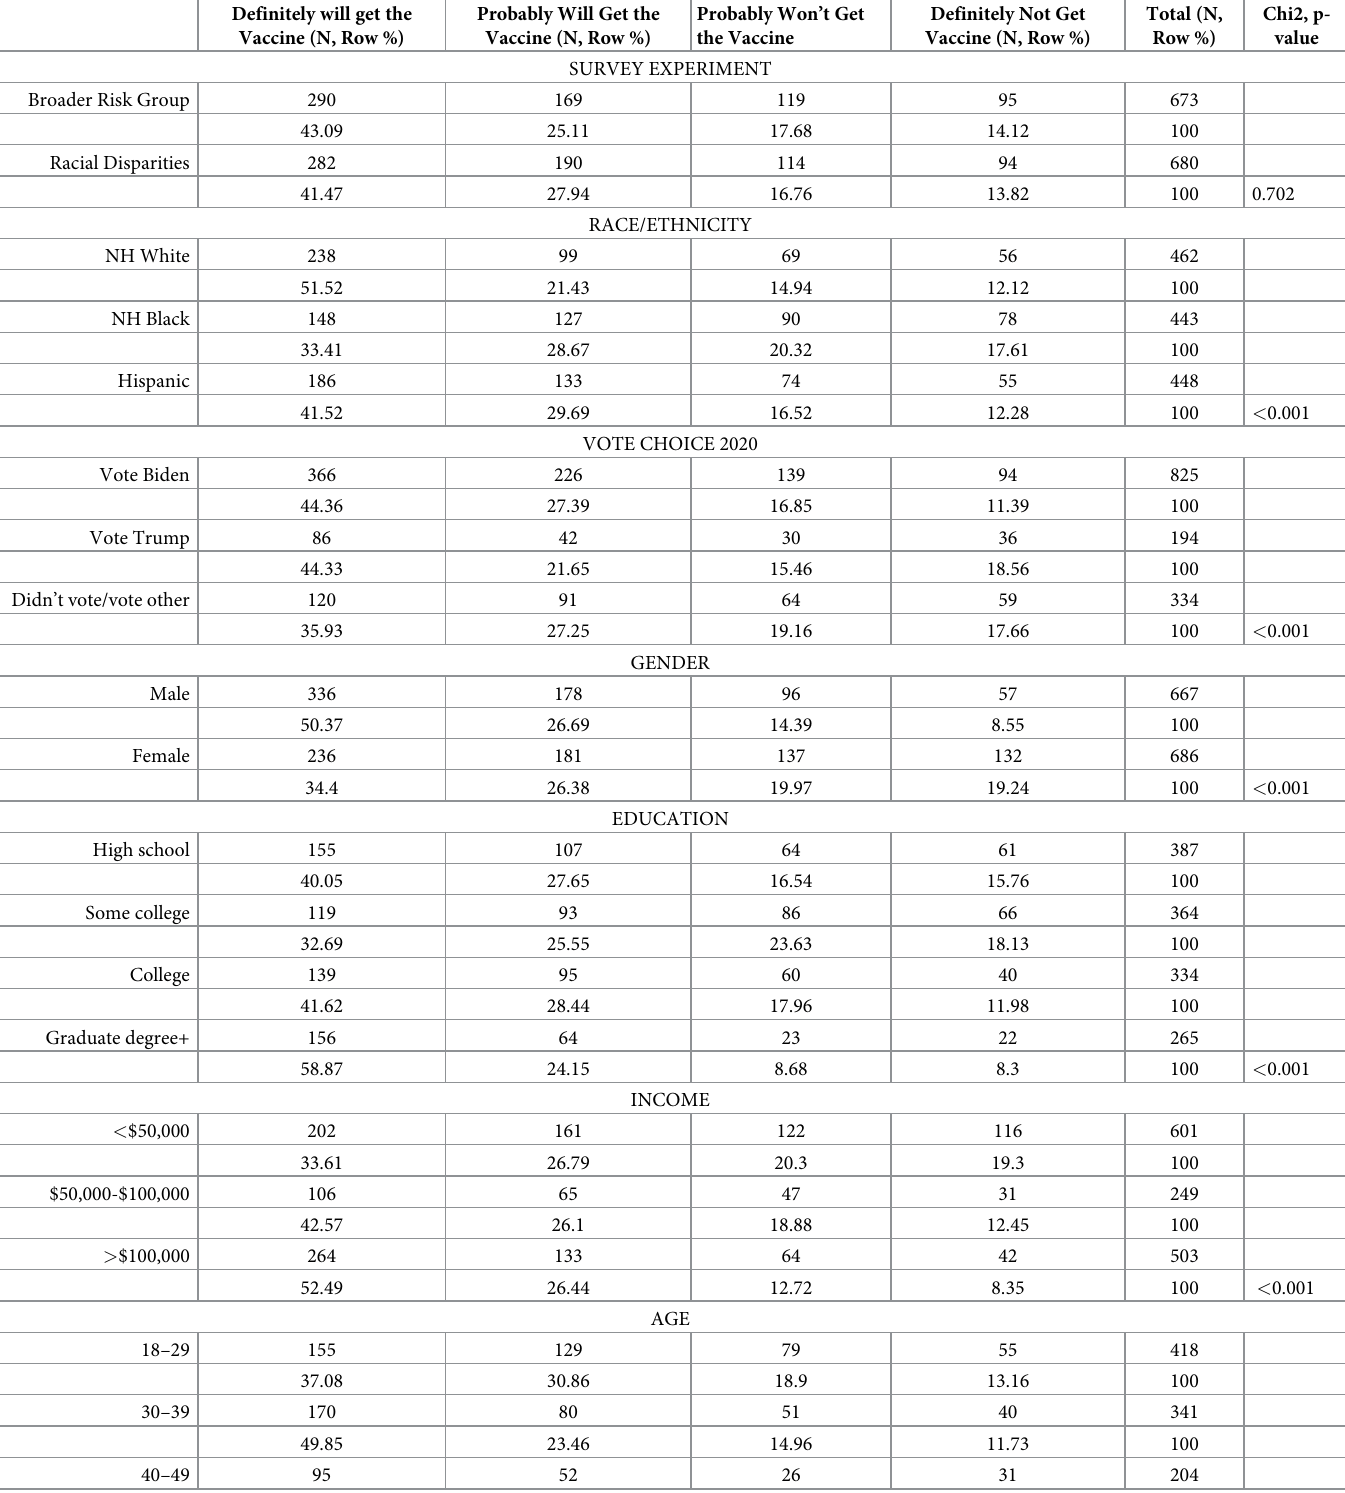
Table 1. Bivariate associations: Vaccine intentions and predictors.